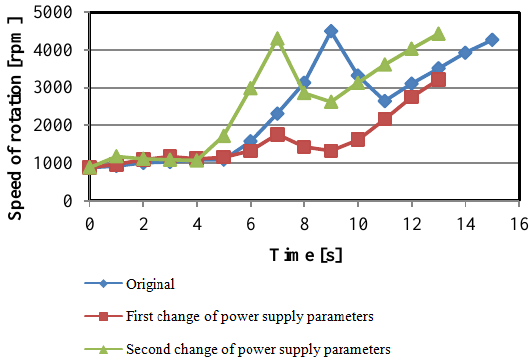
Fig. 9. Changing the rotational speed during acceleration